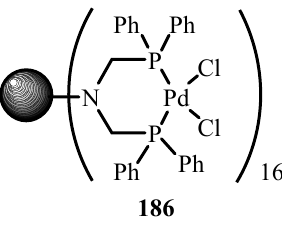
Figure 27. Dendrimer supported catalysts.